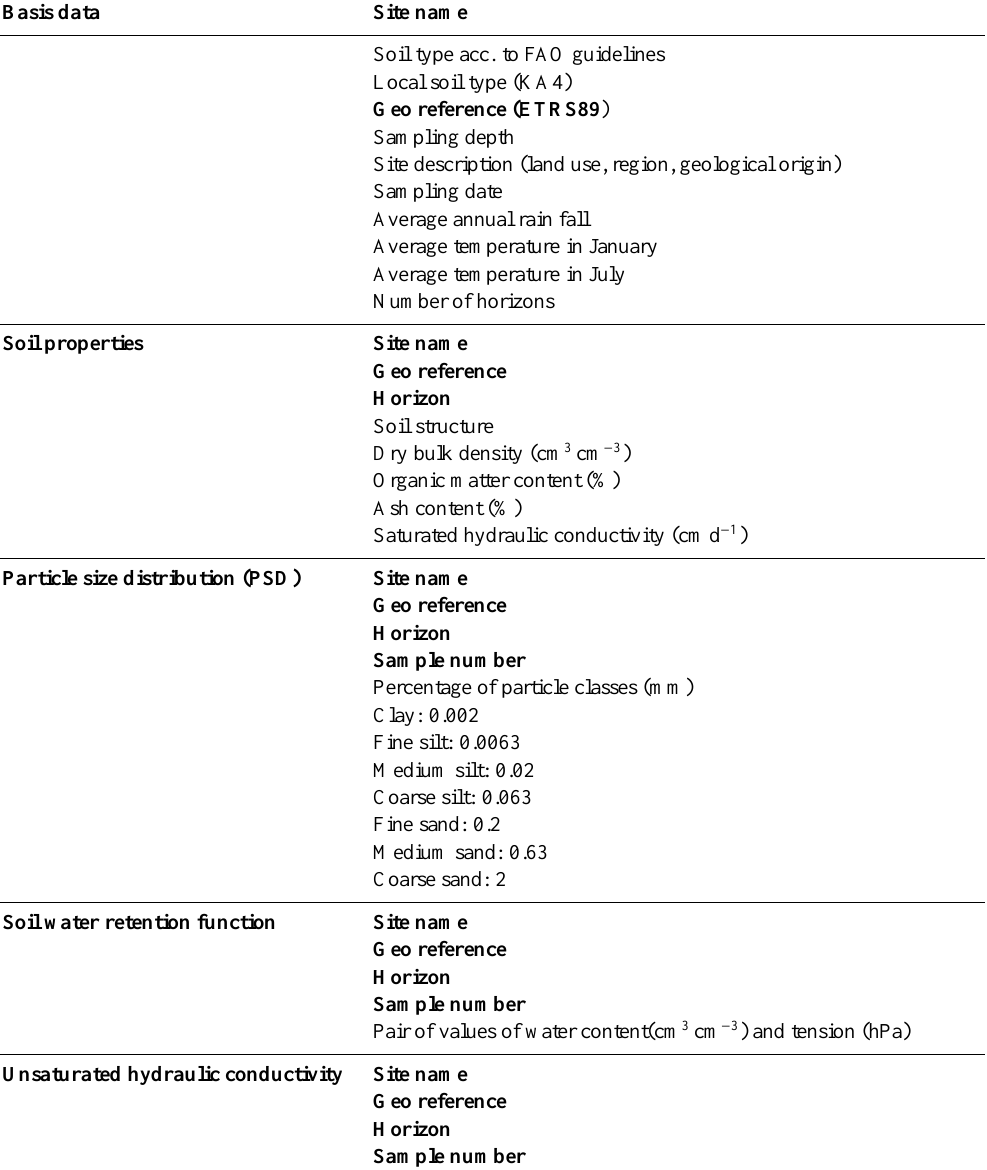
Table 1. Data base content and structure. Basis